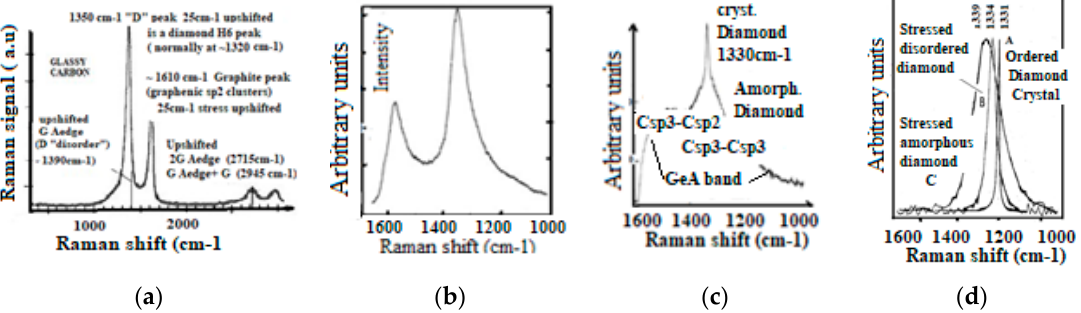
Figure 7. Comparison of Raman spectra of carbon materials that are supposed to be very different. ( a ) Glassy carbon (25 cm − 1 stress up-shift) by Badzian et al. [132] with permission of Les Editions de la Physique. Glassy Carbon (GC) is not always graphitic. In the present case, ordered Diamond H6- (sharp up-shifted peak at ~1350 cm − 1 ). Upshifted G peak (~1610 cm − 1 ). Upshifted Ddisorder (GeA) (1370 cm − 1 ) and G + GeA (2945 cm − 1 ). Note similitude with b. ( b ) Diamond crystals imbedded in graphenic matrix by McNamara et al. [116] with permission of the Journal of Diamond and Related Materials. G peak, D diamond broad peak superimposed on GeA band (so-called D disorder band), ( c ) Superimposed D diamond peak with D diamond band and GeA band by Mc Namara et al. [116] showing existence of DG band (~1450 cm − 1 ) and DD band (~1140 cm − 1 ) with permission of the Journal of Diamond and Related Materials.. (Necessity of di ff erentiating the D designation. ( d ) Comparison of (A) ordered diamond (B) disordered diamond (C) amorphous diamond broader peak (B) and (C) with stress shift by P.H. Huong et al. [173] with permission of the Journal of Diamond and Related Materials.